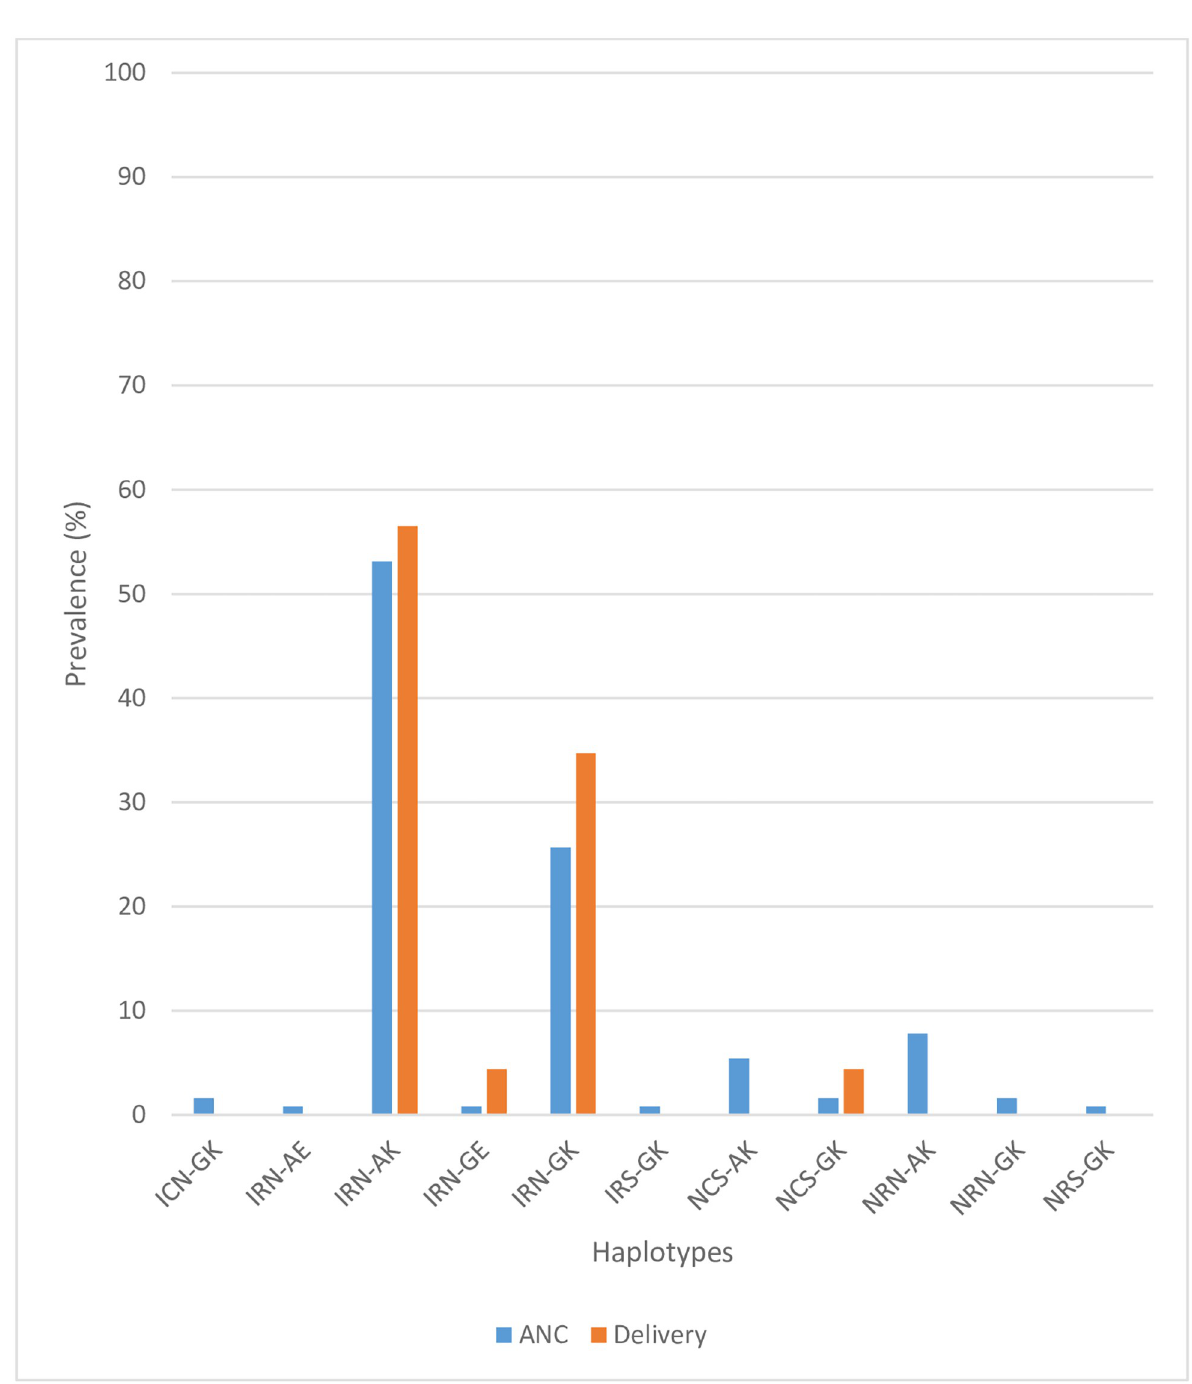
Fig 1. Prevalence of combined Pfdhfr (codons 51/59/108) and Pfdhps (codons 437/540) haplotypes at first ANC and at delivery. https://doi.org/10.1371/journal.pone.0271489.g001 Complete data for the combined Pfdhfr 51/59/108 and Pfdhps 436/437/540/581/613 was available for 114 and 22 samples collected at ANC and at delivery respectively (Table 4). A total of 21 and 6 distinct haplotypes were obtained from the combined Pfdhfr and Pfdhps hap- lotypes. The wild type haplotype (NCS-SAKAA) were carried by 1.7% (2/114) of isolates at